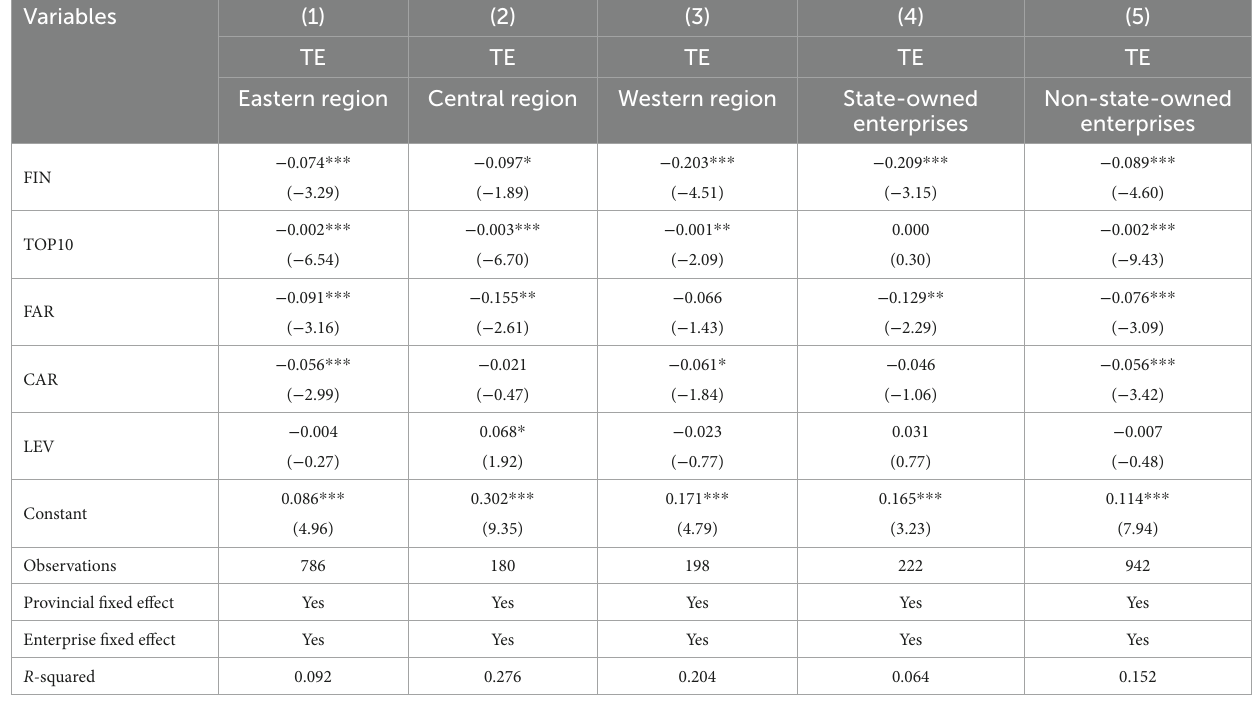
TABLE 6 Sub-regional regression results and regression results of enterprise nature.